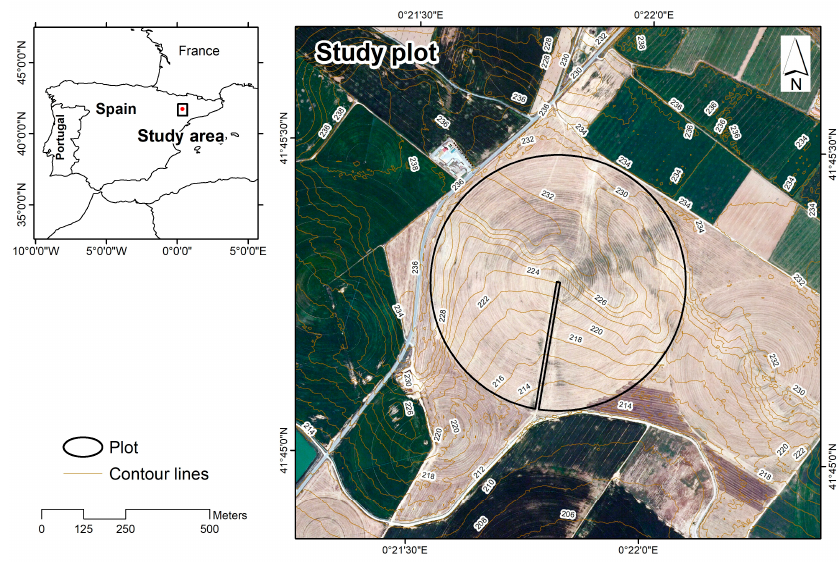
Figure 1. Location of the study area.